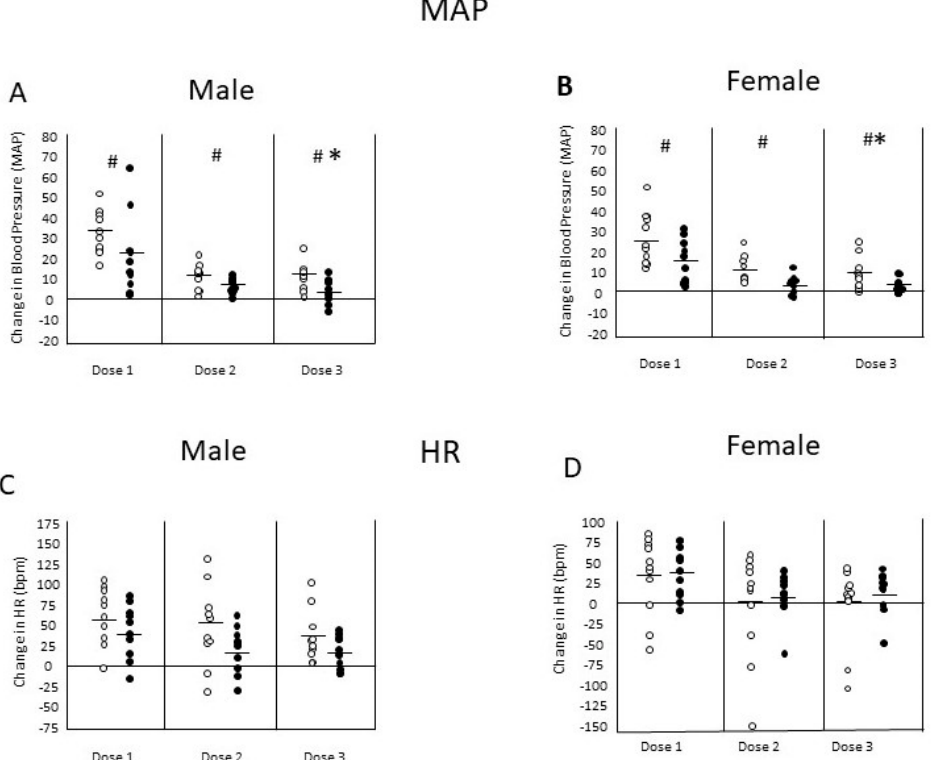
Figure 3. Changes in mean arterial pressure (MAP) and heart rate (HR) elicited by 3 consecutive doses of MA (2 mg/kg, i.v.) in male (n = 10) and female (n = 11) Sprague-Dawley rats, prior to and after passive immunization with anti-MA antibodies. ( A , B ) changes in MAP elicited by MA in male and female rats, respectively. Pressor responses were significantly (* = p < 0.05) reduced between the first and third MA dosings in male and female rats. After immunization, the pressor responses to MA were significantly (# = p < 0.05) smaller than during control (treatment effect). ( C , D ) changes in HR elicited by MA in male and female rats, respectively. There was a significant effect of dose on HR, but no significant differences in the HR responses before and after immunization (treatment